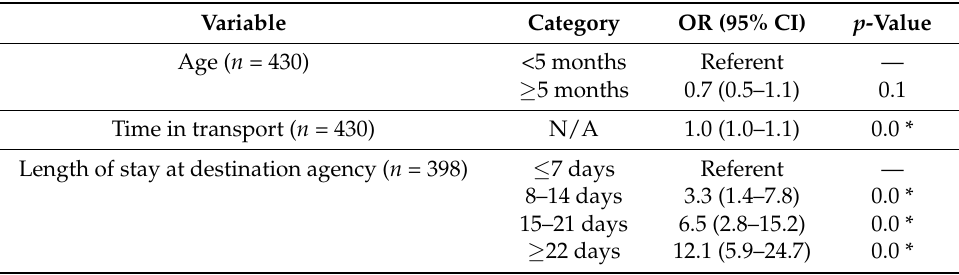
Table 2. Univariable logistic regressions of factors associated with URI at the destination agency.